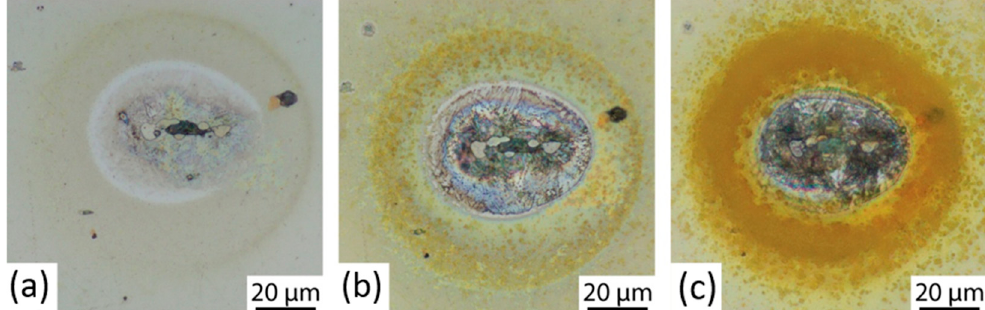
Figure 7. Corrosion pit, 1.5Al-3Mn-HT steel; ( a ) 1 min, ( b ) 5 min, ( c ) 20 min immersion (demineralized water).